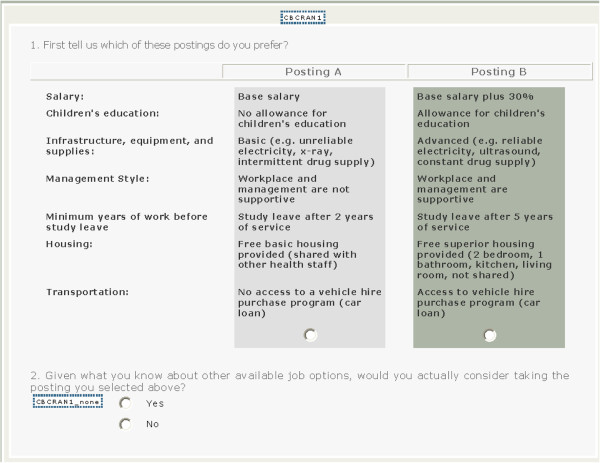
Sample DCE question.